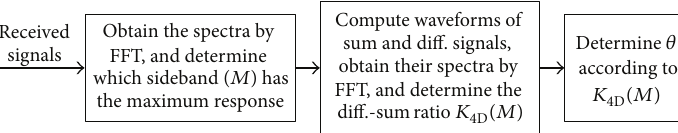
Figure 13: Signal processing steps in the 4D array for direction